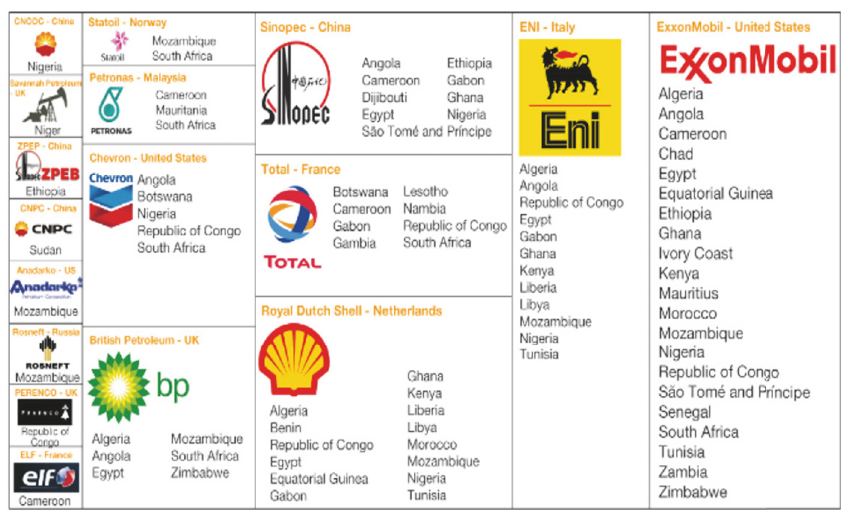
Figure 1: International oil companies operating in Africa. Source: http://atlantablackstar.com/2016/10/25/international-oil-companies- competing-operate-investment-africa/.